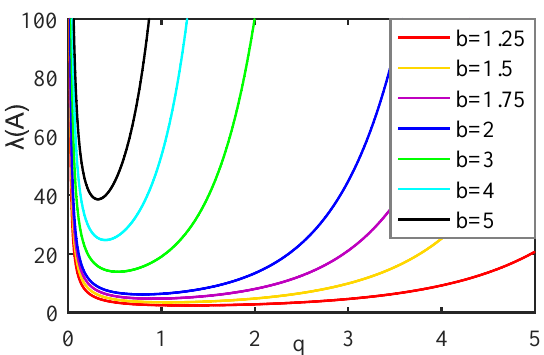
Figure 6. Curve of λ ( A ) under different